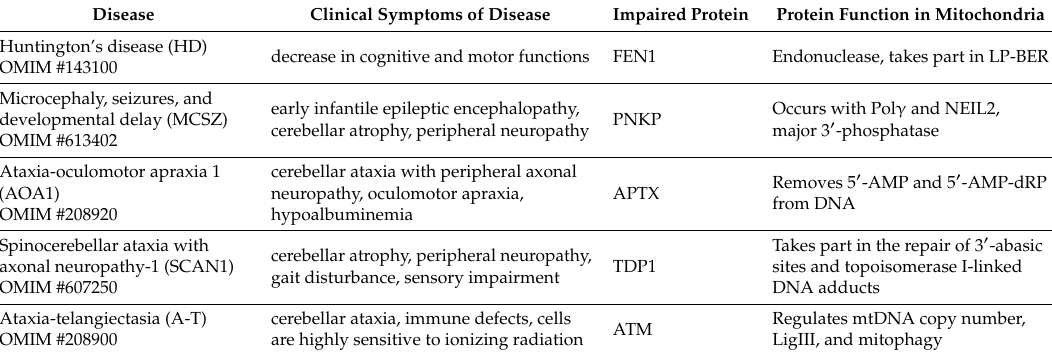
Table 2. Examples of diseases related to mitochondrial repair system; FEN1—flap